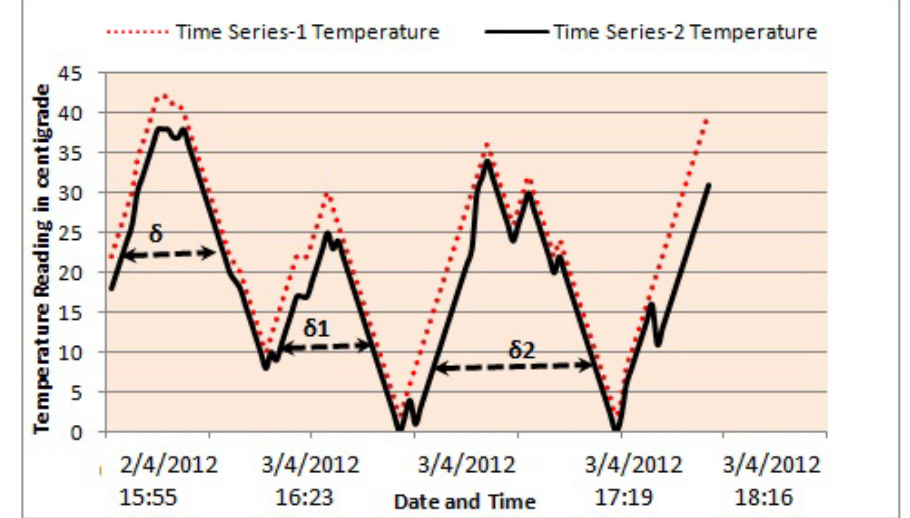
Figure 2. Sliding window-based control parameter to reduce the total number of comparisons needed to find a match in both data sets. Here, the x -axis shows the time of the collected temperature data, and the y -axis shows the value of the data in ◦